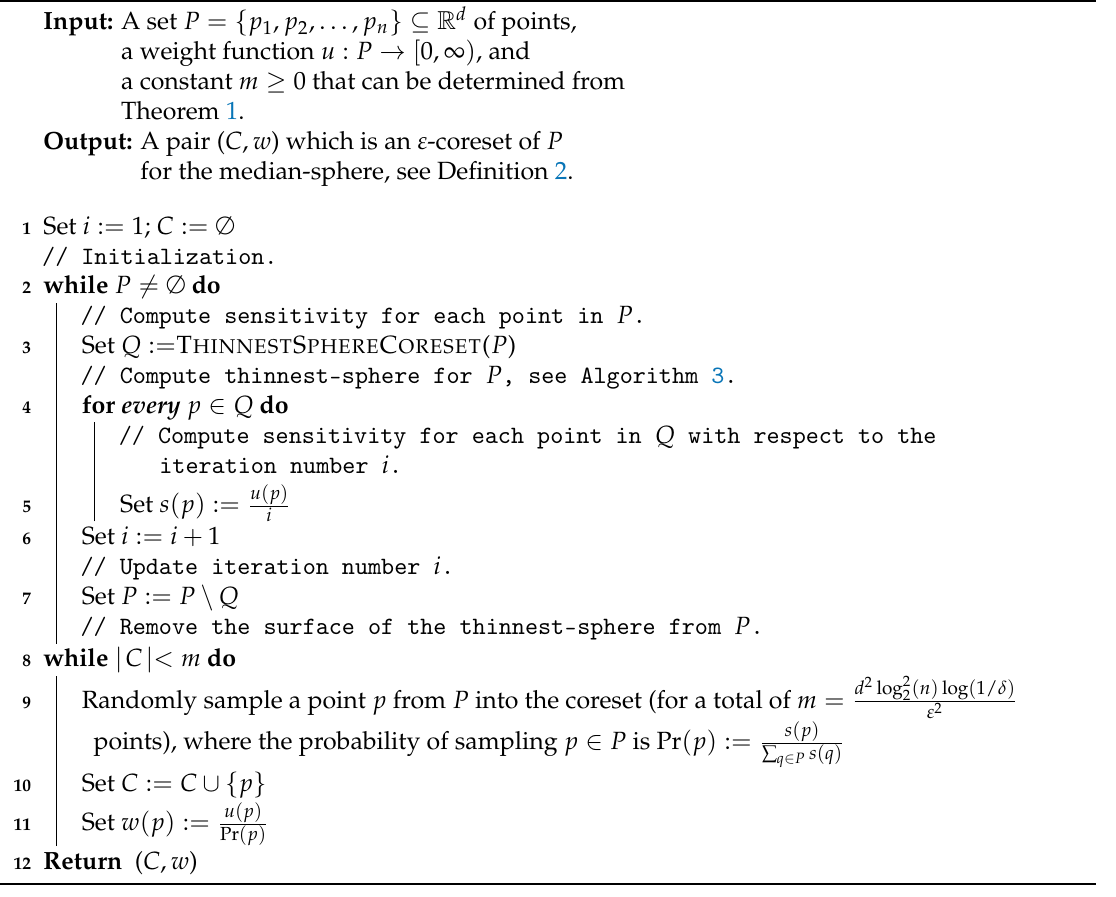
Algorithm 2: M EDIAN S PHERE C ORESET ( P , u , m